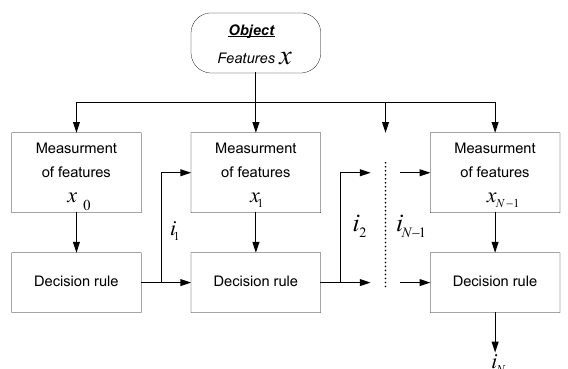
Figure 1. Bayesian hierarchical classifi